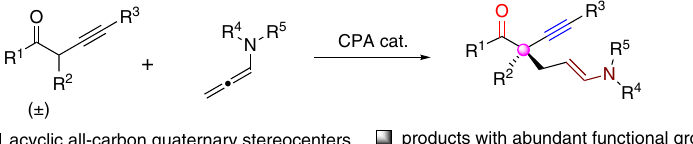
Fig. 1 Asymmetric construction of all-carbon quaternary stereocenters via enantioselective functionalizations of α -branched ketones. a Asymmetric construction of quaternary stereocenters of activated ketones. b Asymmetric construction of quaternary stereocenters of α -branched cyclic ketones. c Unsaturation-enabled asymmetric Mannich reaction of α -branched acyclic ketones. d Asymmetric construction of acyclic quaternary stereocenters of α - alkynyl acyclic